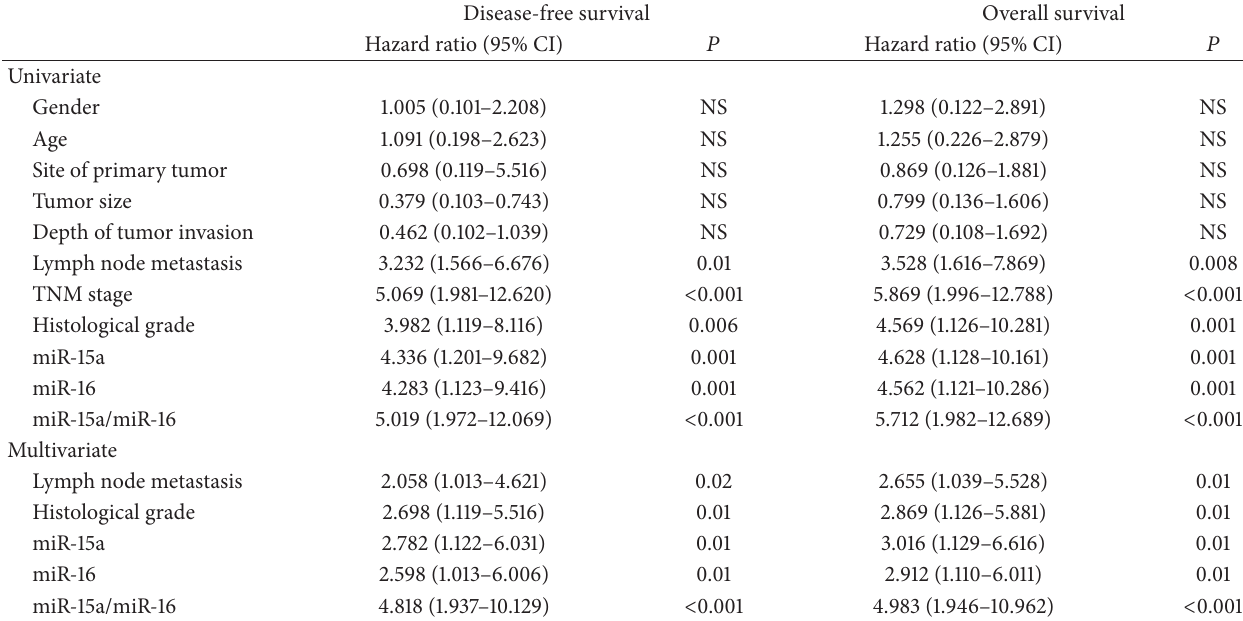
Table 2: Prognostic value of combined miR-15a and miR-16 expression for the disease-free survival and overall survival in univariate and multivariate analyses by Cox